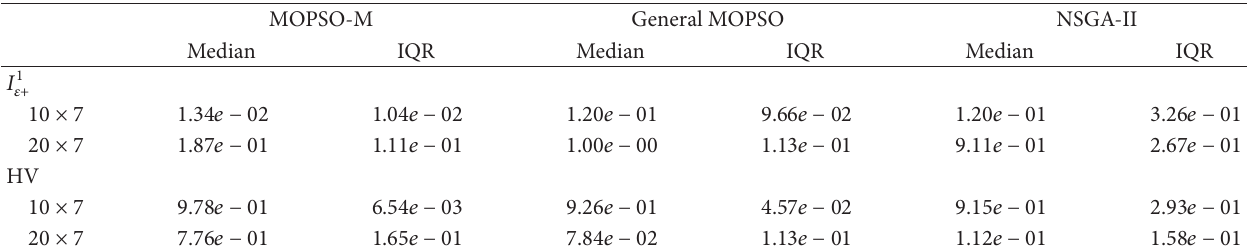
Table 4: Median and IQR of the 𝐼 1 𝜀+ and HV indicators.